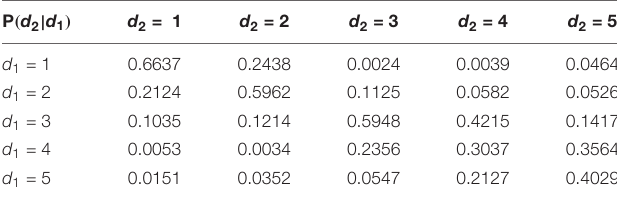
TABLE 6 | The optimal CPD P ( d 2 | d 1